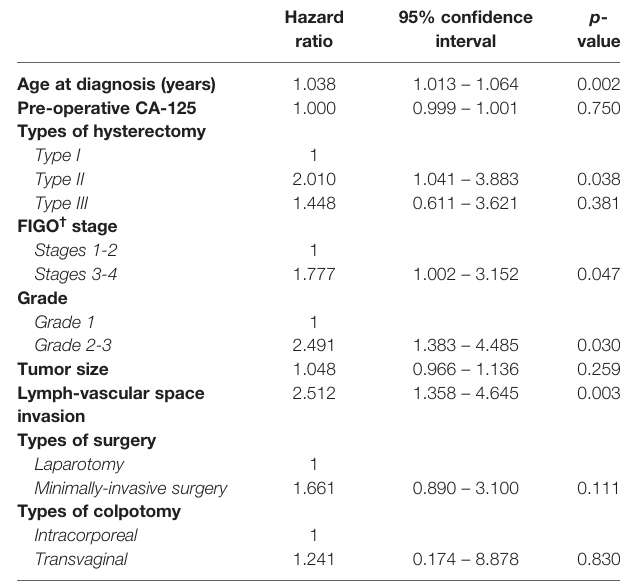
† FIGO, International Federation of Gynecology and Obstetrics.